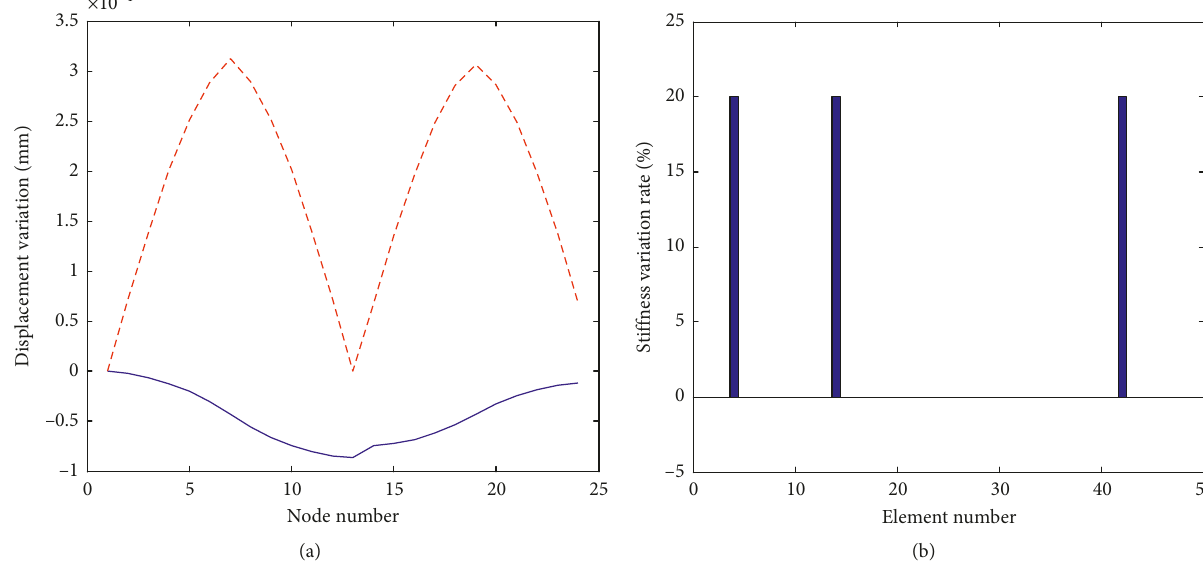
Figure 7: Numerical results using the complete noise-free measurement data: (a) displacement variations; (b) stiffness variation rate. In (a), the solid line indicates the horizontal displacement and the dashed line indicates the vertical